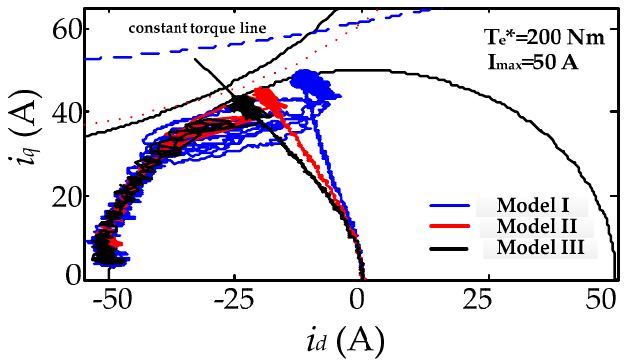
Figure 11. Simulation result of current trajectory when torque command is limited to 200 nm.